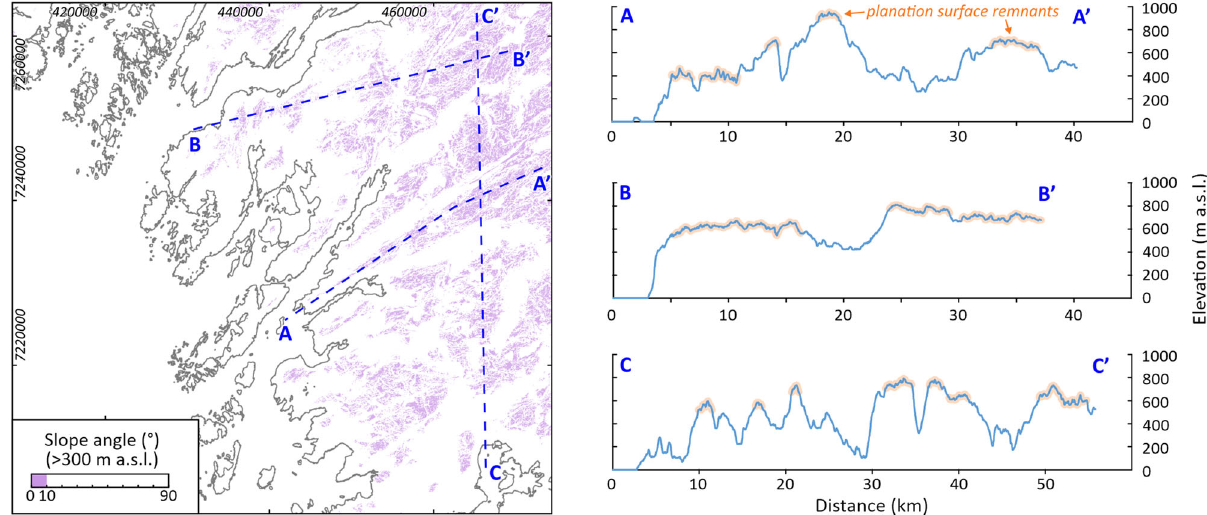
Fig. 3 Elevated planation surface remnants. Left panel: Slope angle map showing distribution of fl at (<10°) areas at elevation >300 m a.s.l., which are interpreted as planation surface remnants. Note that these planation surface remnants are preserved at summit levels as indicated on the topographic pro fi les (panels on the right). Traces of the pro fi les are indicated on the left